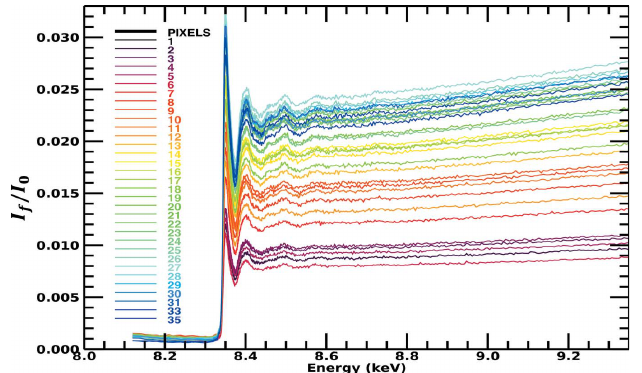
Figure 1 Raw fluorescence spectra for the nickel i -pr complex, demonstrating the large dispersion between spectra collected by individual pixels. This is well known and common in XAS fluorescence-mode data collection.